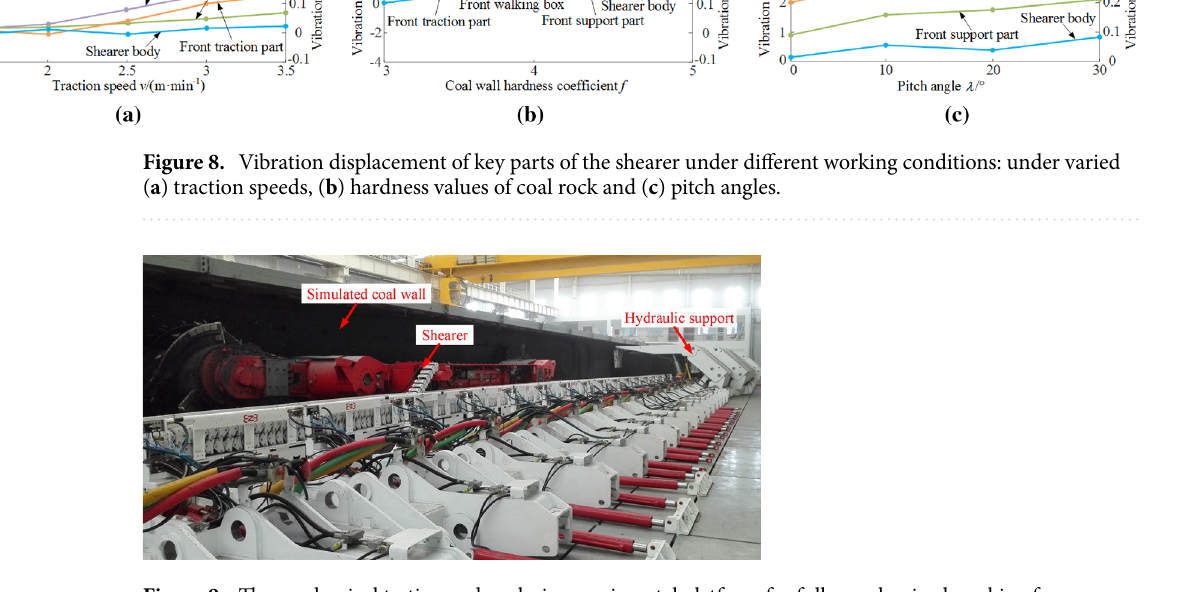
Figure 9. The mechanical testing and analysis experimental platform for fully mechanized working